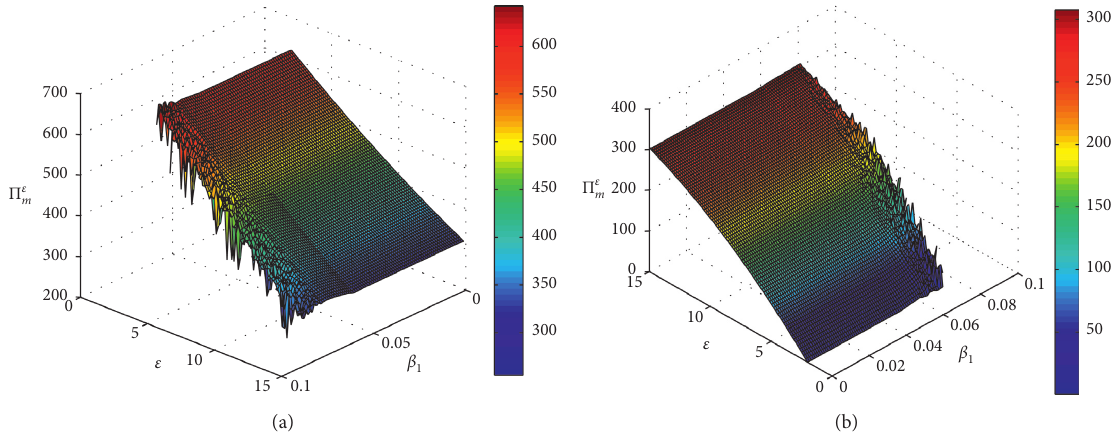
Figure 34: 3D profit diagrams of the manufacturer and retailer with β manufacturer. (b) 3D profit diagrams of the retailer.